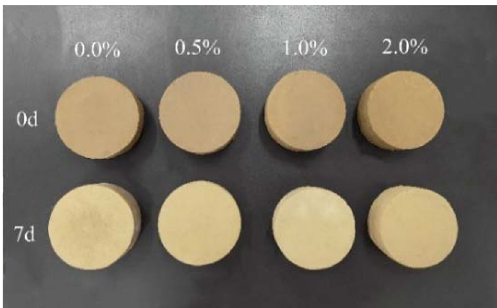
Figure 3. Photographs of splitting tension test